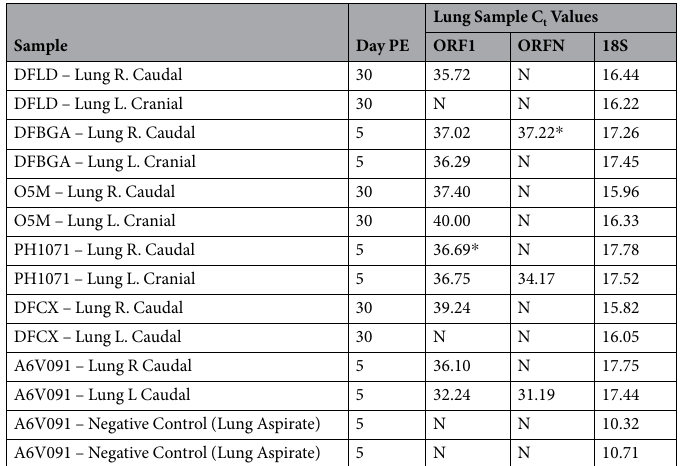
Table 1. icMERS-0 RNA from FFPE lung tissue. C t values represent an average of duplicate samples. N is none detected. * Represents a single value obtained for duplicate